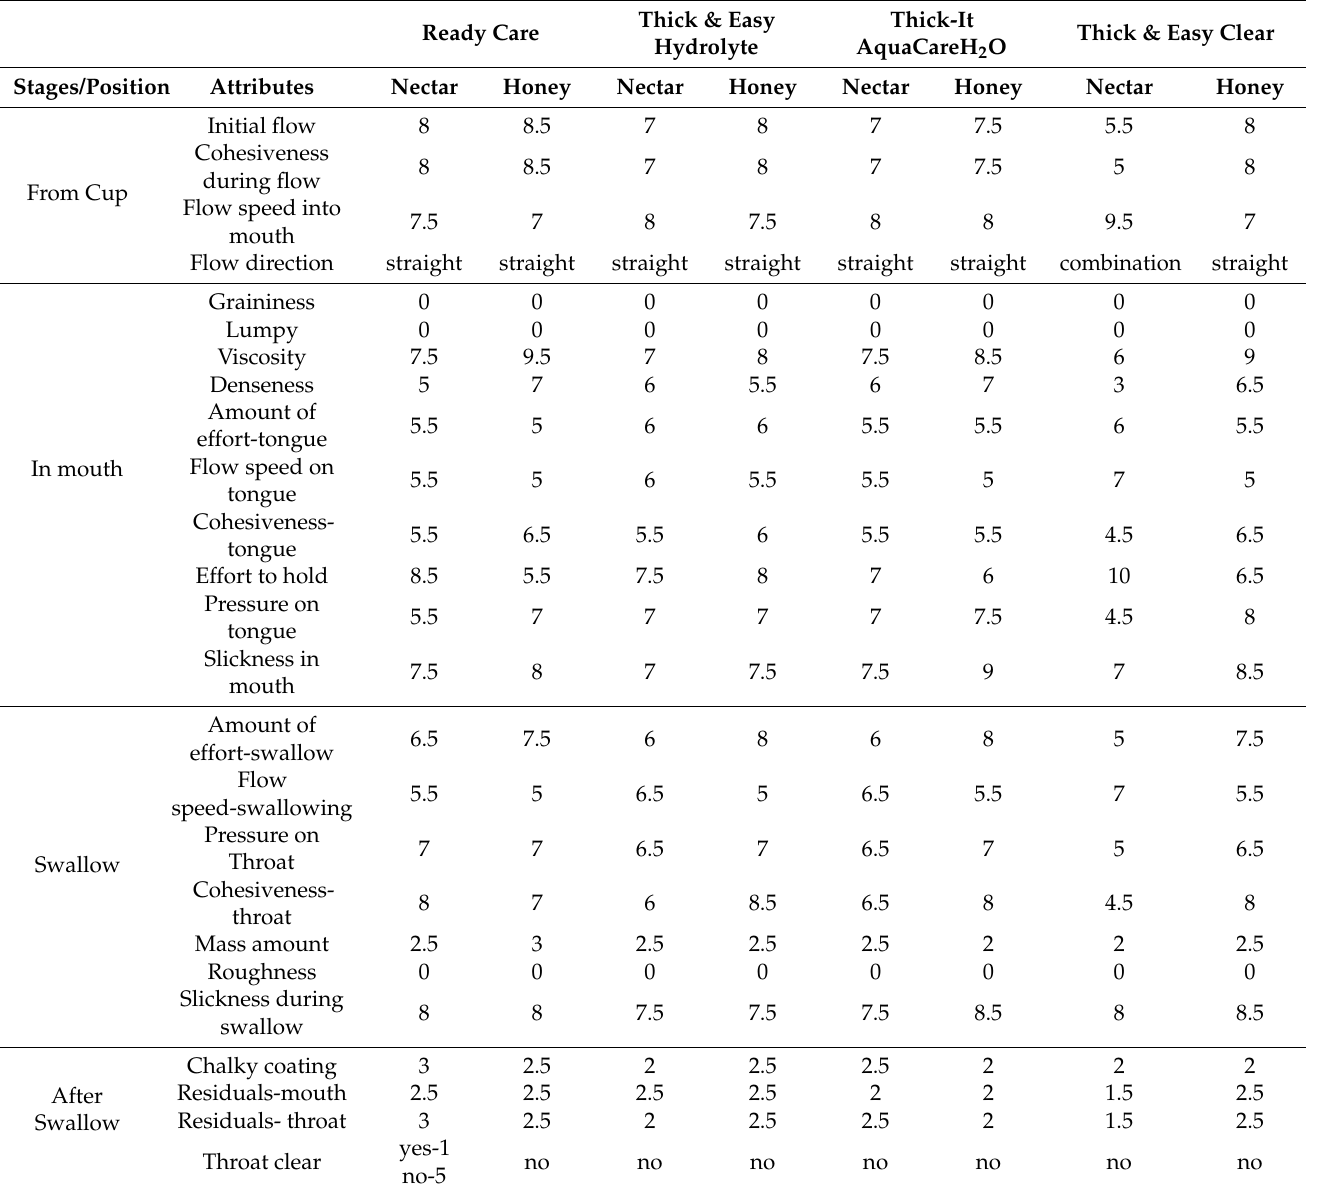
Table 3. Texture attributes and intensities a